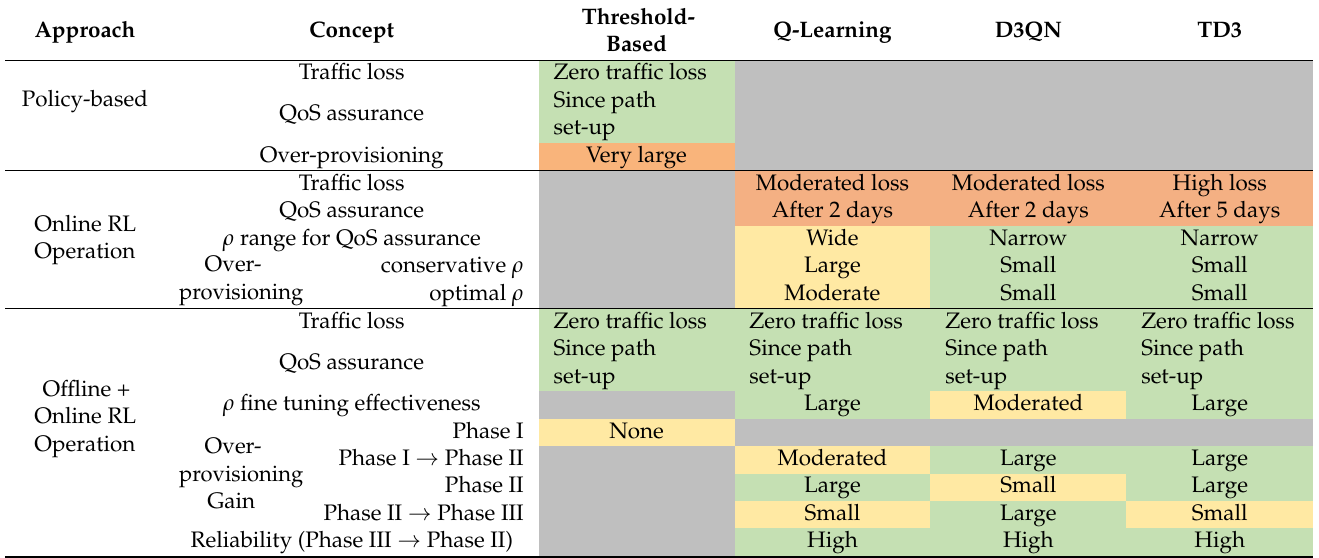
Table 5. Summary of results for policy-based and RL operation with and without offline